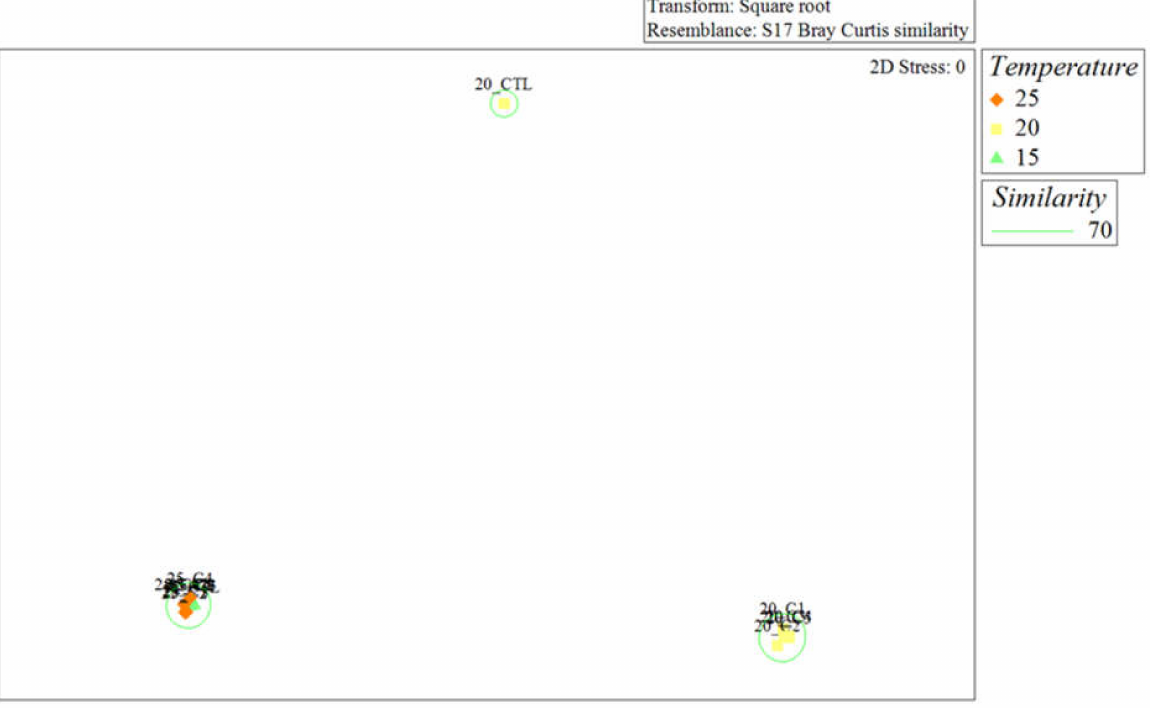
Figure 11. Two-dimensional non-metric MDS ordination plot of the neutral sugar content of T. weissflogii exposed to copper sulfate at the three